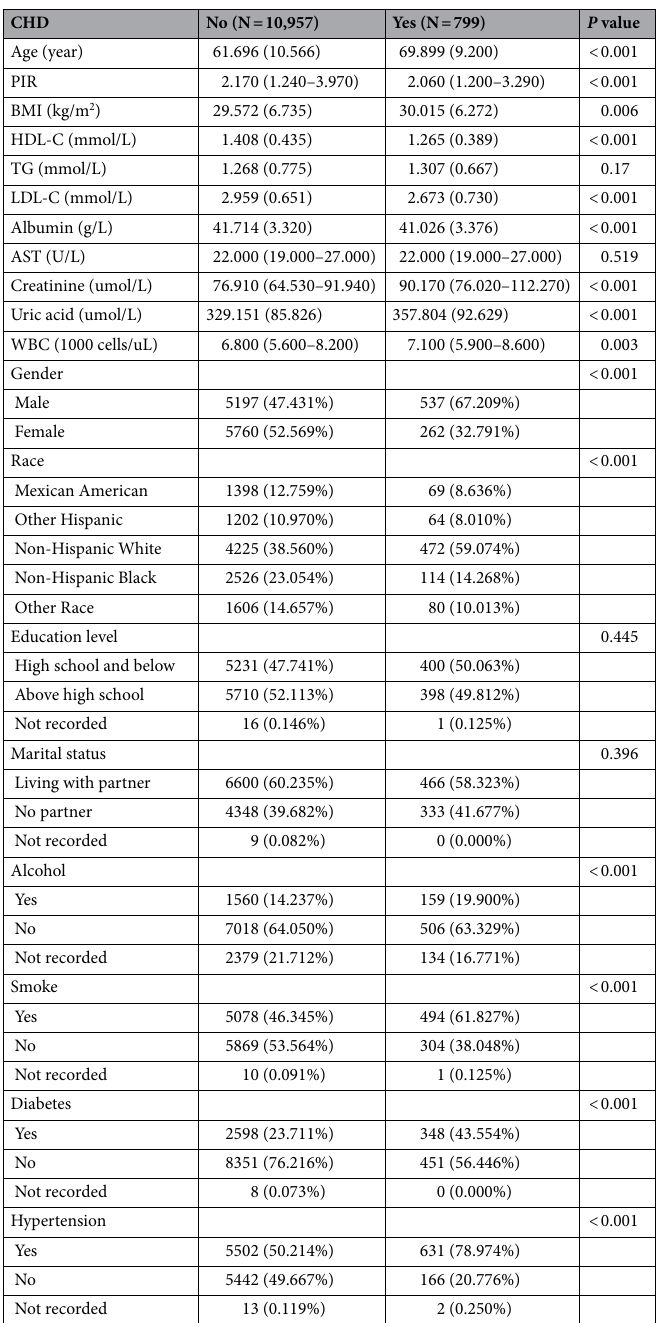
Table 1. Characteristics of the study population. CHD: coronary heart disease; PIR: family income poverty ratio; BMI: body mass index; HDL-C: high density lipoprotein cholesterol; TG: triglyceride; LDL-C: low density lipoprotein cholesterol; AST: aspartate aminotransferase; WBC: blood white blood cell